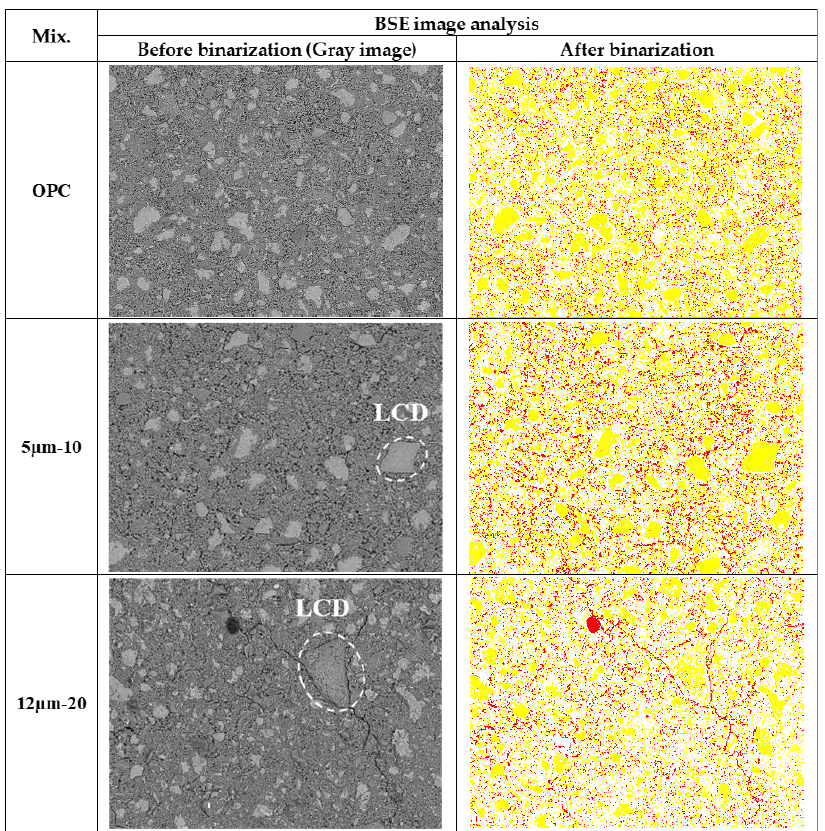
Figure 6. Example images before and after binarization for cement pastes at 14 days (pore: red, hydrated product: white, un-hydrated product: yellow).